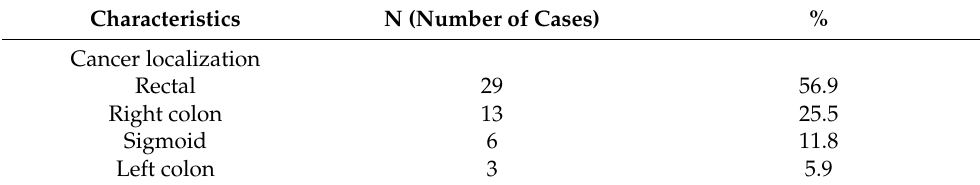
Table 2. The frequency of cancer localization.